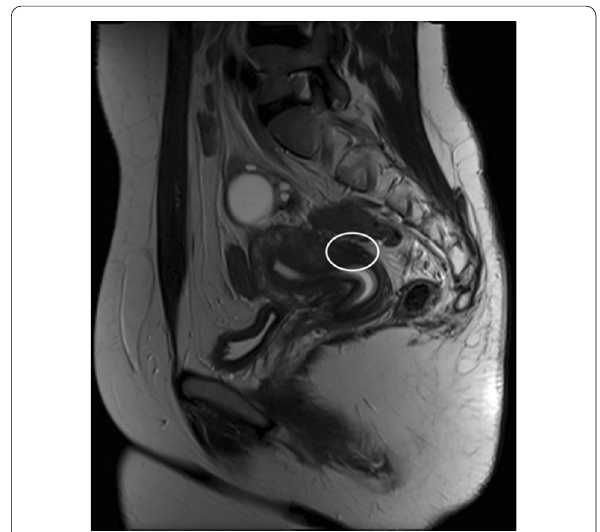
Fig. 3 T2 weighted sagittal MRI image showed involvement of retrocervical region as a site of DIE with some adhesions in the posterior cul-de-sac